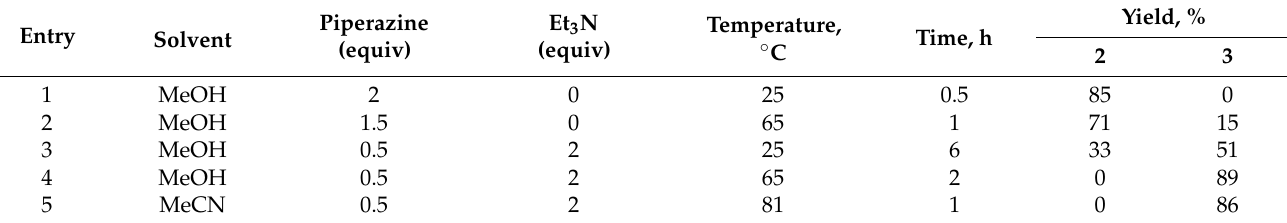
Table 1. Reaction of 4,5-dichloro-3 H -1,2-dithiol-3-one 1 with piperazine.